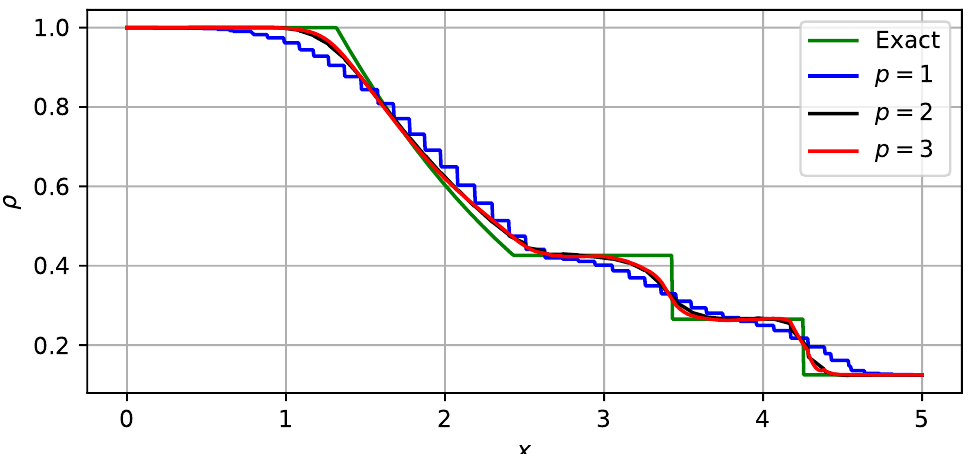
Figure 15. Third-order solution of ρ ( t = 0.3 ) in Problem 5.